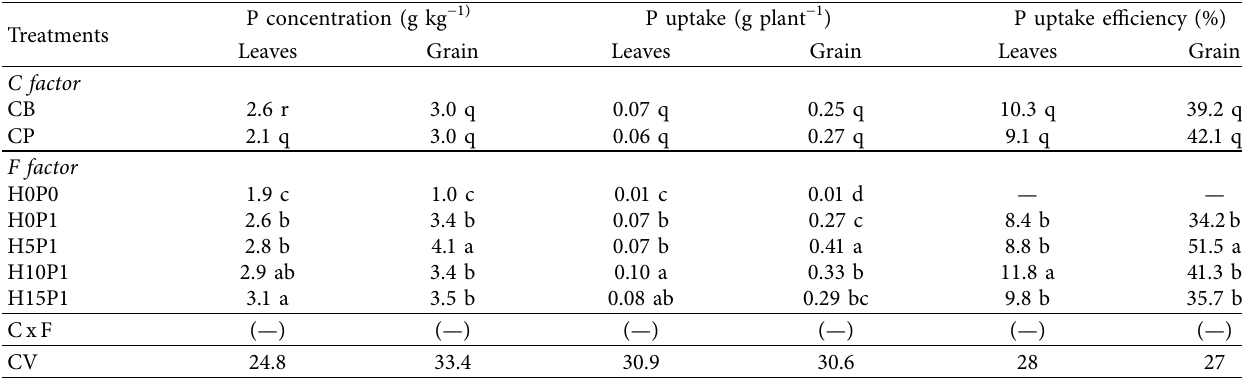
Table 3: P concentrations in the crop tissues, crop uptake, and uptake efficiency in the two corn cultivars treated with humic acid extracted from the composted manure (MHA) and phosphorus (P) 15weeks after planting. Treatments